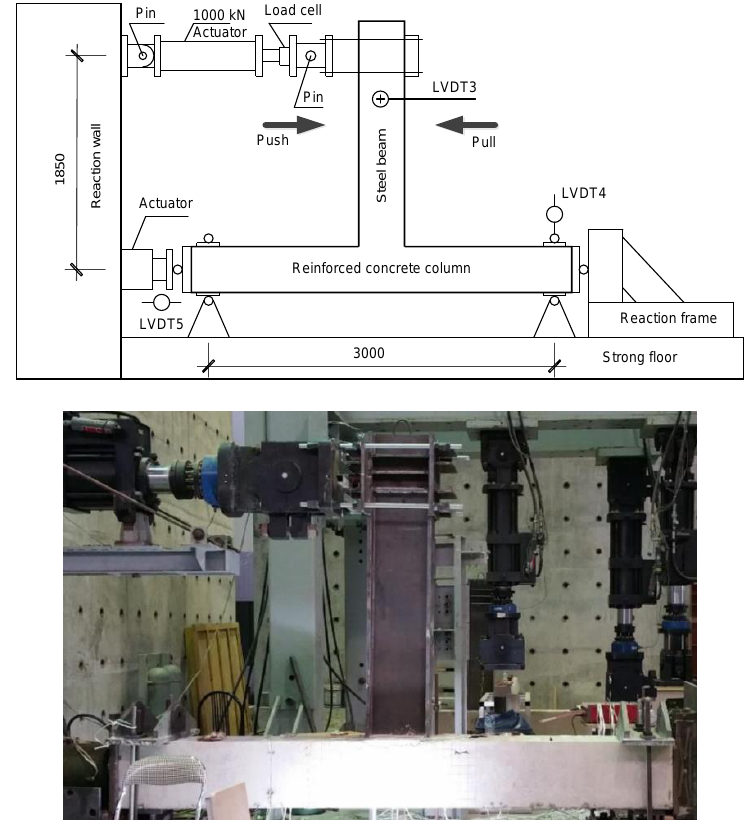
Figure 4. Test setup.